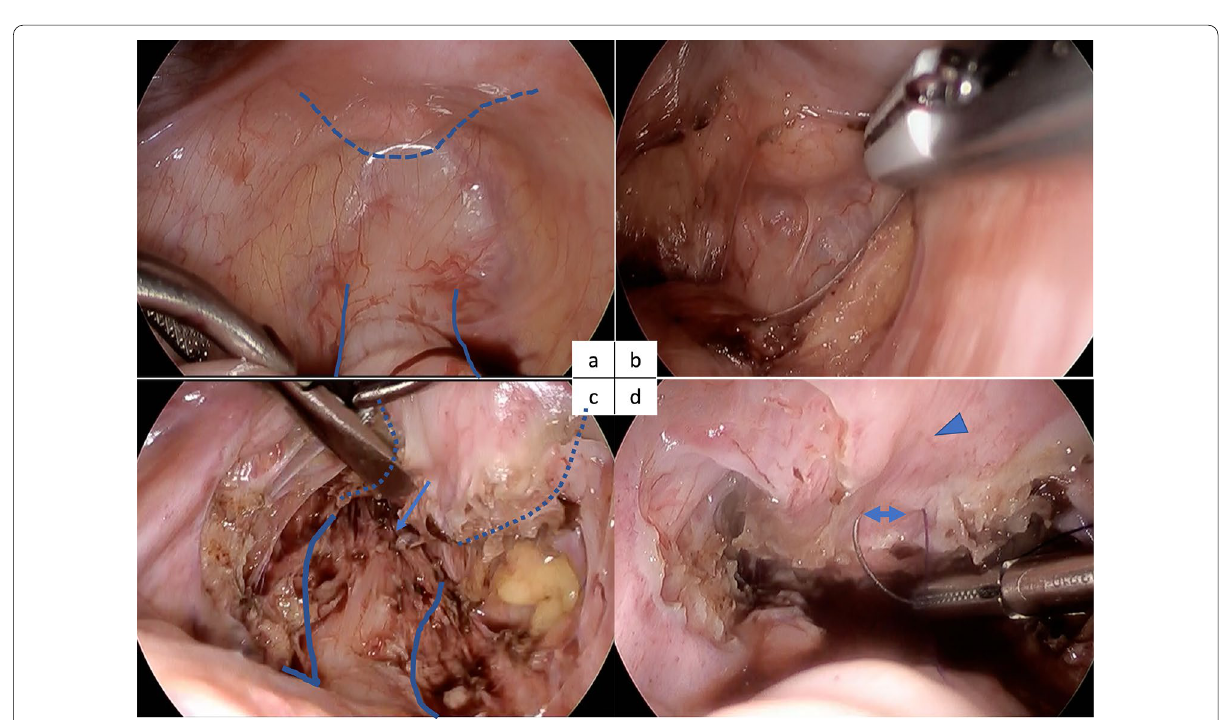
Fig. 5 Laparoscopic view of the radical surgery. a Uterus (dashed line) and rectum (blue line) are exposed. b Separation between the vagina and rectum. c Ventral wall of the rectum (lined) is exposed and a marking suture (single arrow) for the distal end of the tumor is placed through the vagina (lined by dots). d A marked suture (double arrow) is visible at the proximal end of the tumor near the cervix